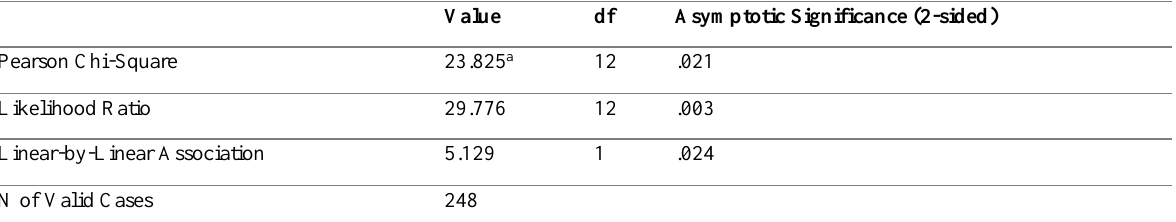
Table 6 : Influence of Cost Control on Realization of NG-CDF